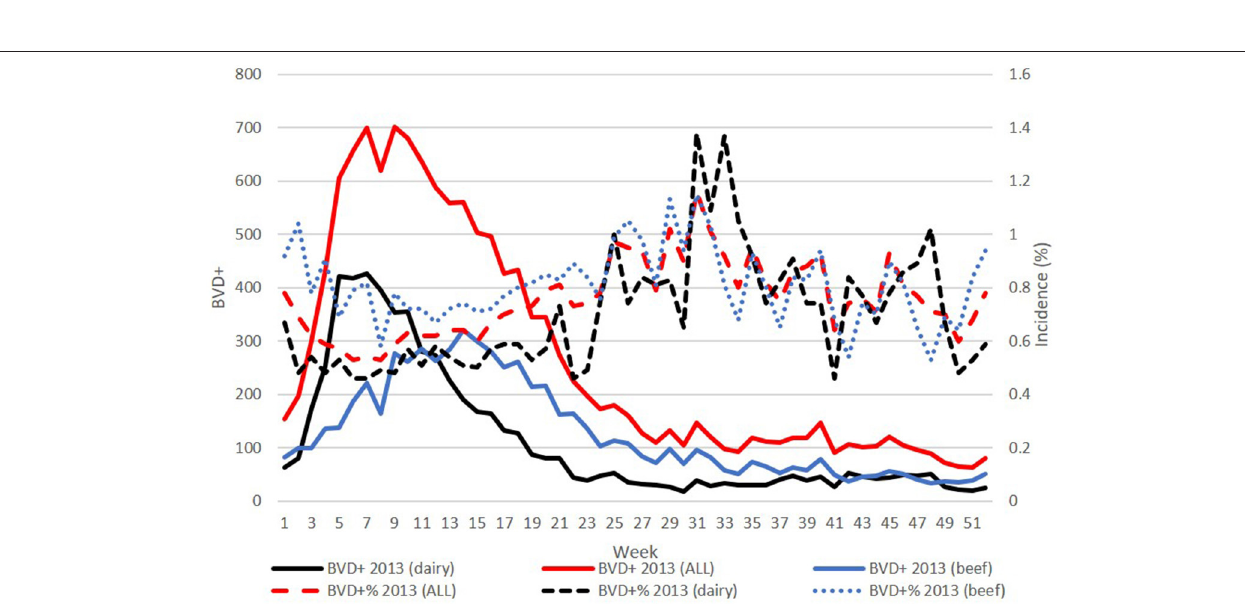
at 0.78 and 0.55%, respectively, in 2013), while the